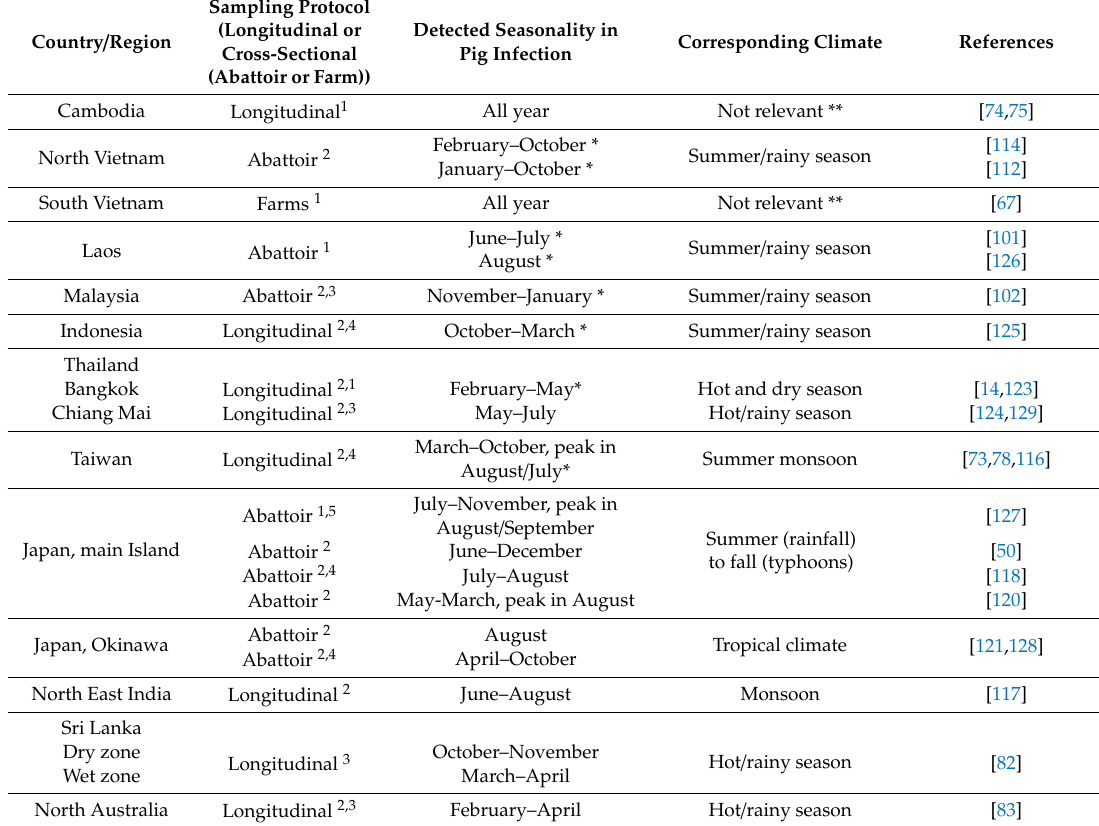
Table 7. Detected seasonality in JEV infection in